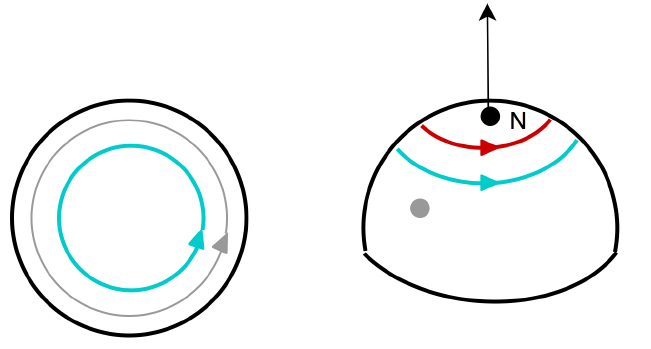
2 πτ t E (to the rest 1 , 2 → φ 1 , 2 − β in the rest 3